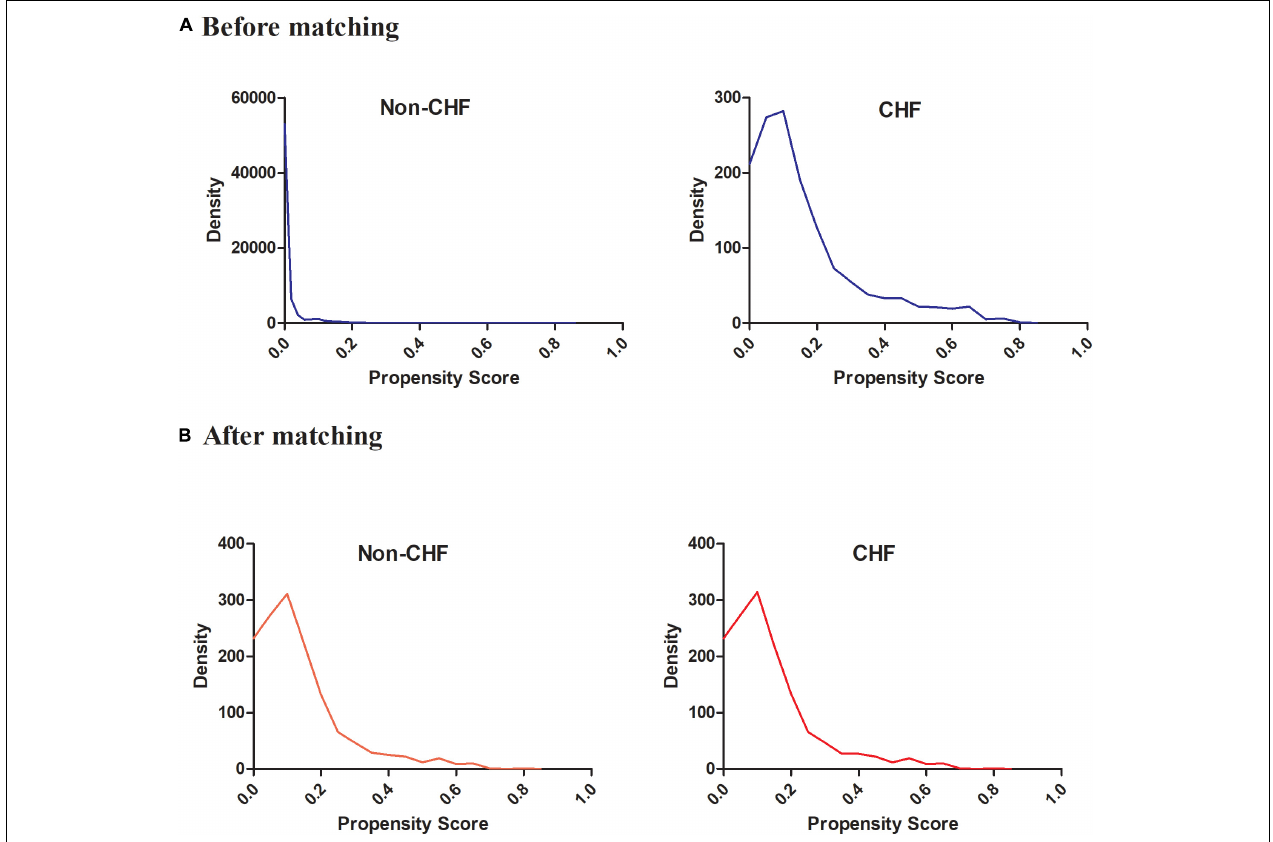
FIGURE 3 | The probability density functions of the propensity score for CHF and non-CHF participants (A) before matching and (B) after matching. It showed the probability density functions of the propensity score for congestive heart failure and non-congestive heart failure participants before matching and after matching.